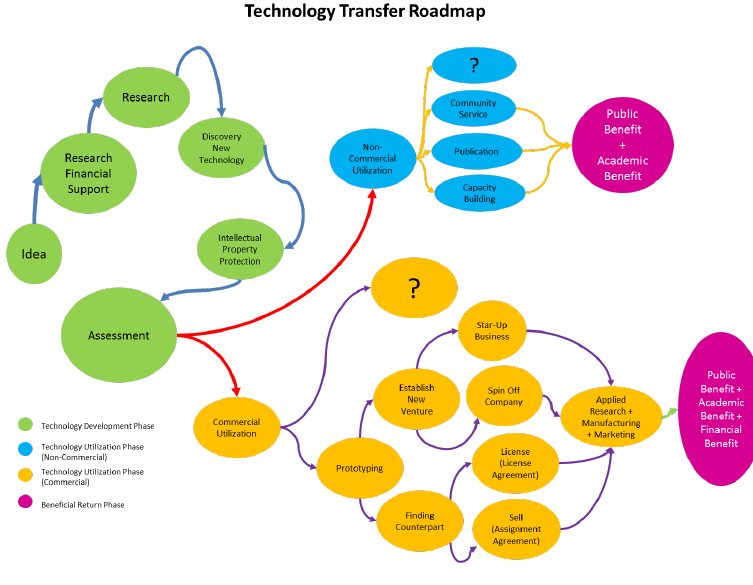
Figure 2. 3 Phases of University Technology Transfer Road